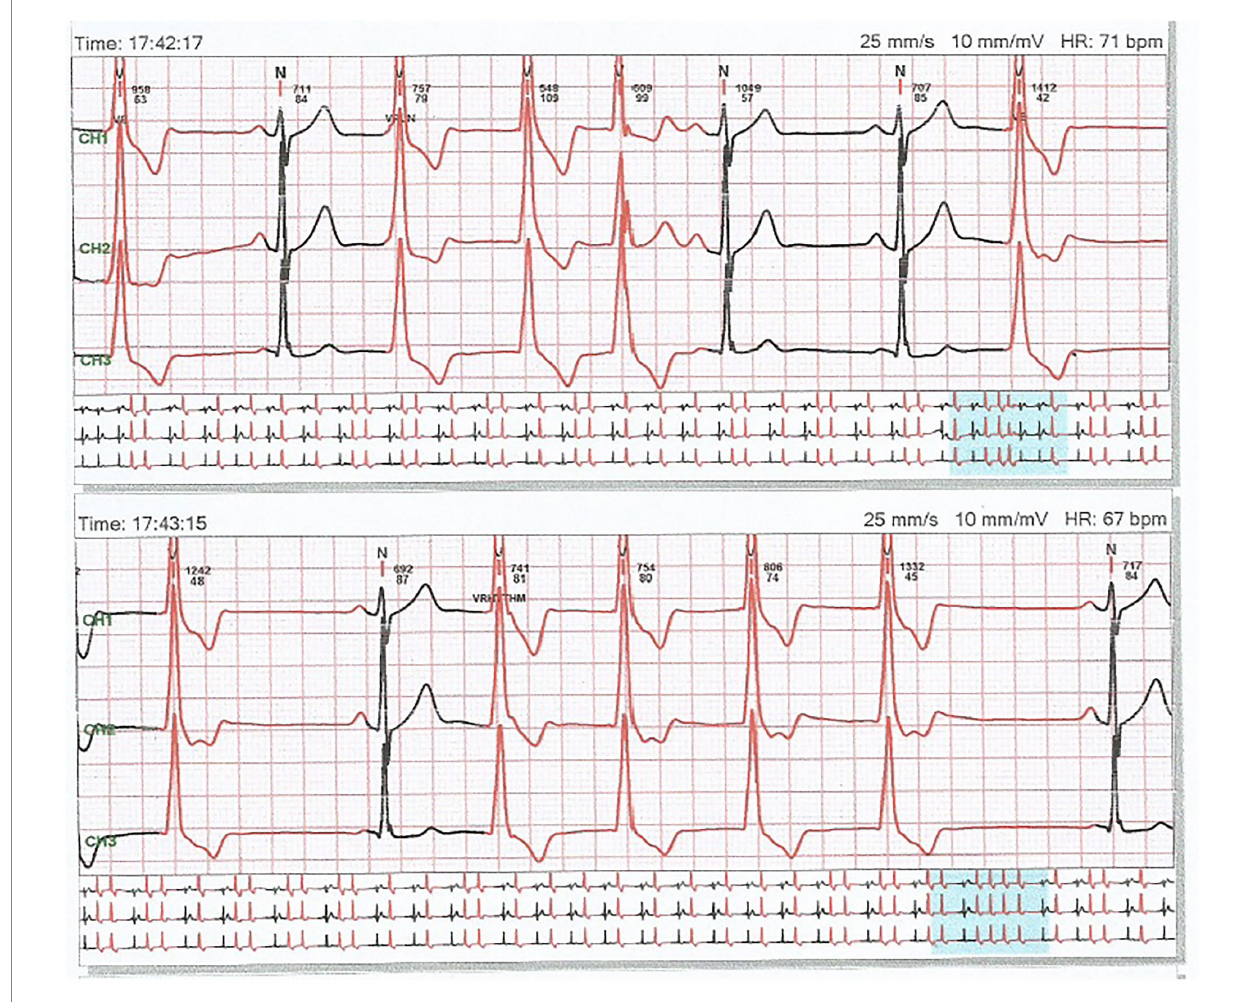
FIGURE 2 A 24 h recording of electrocardiogram showing frequent premature ventricular beats with unique morphology, mimicking a right bundle branch